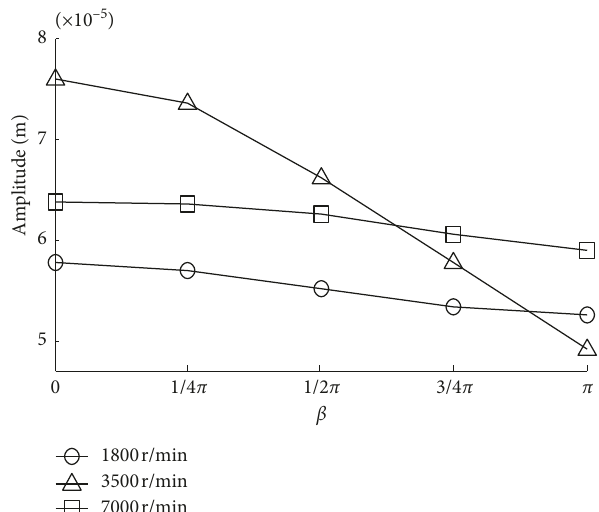
Figure 16: Vibration amplitude versus unbalance orientation angle for different rotation speeds with r � 0 . 4, ε � 1 × 10 − 5 m, and ζ � 0.01.